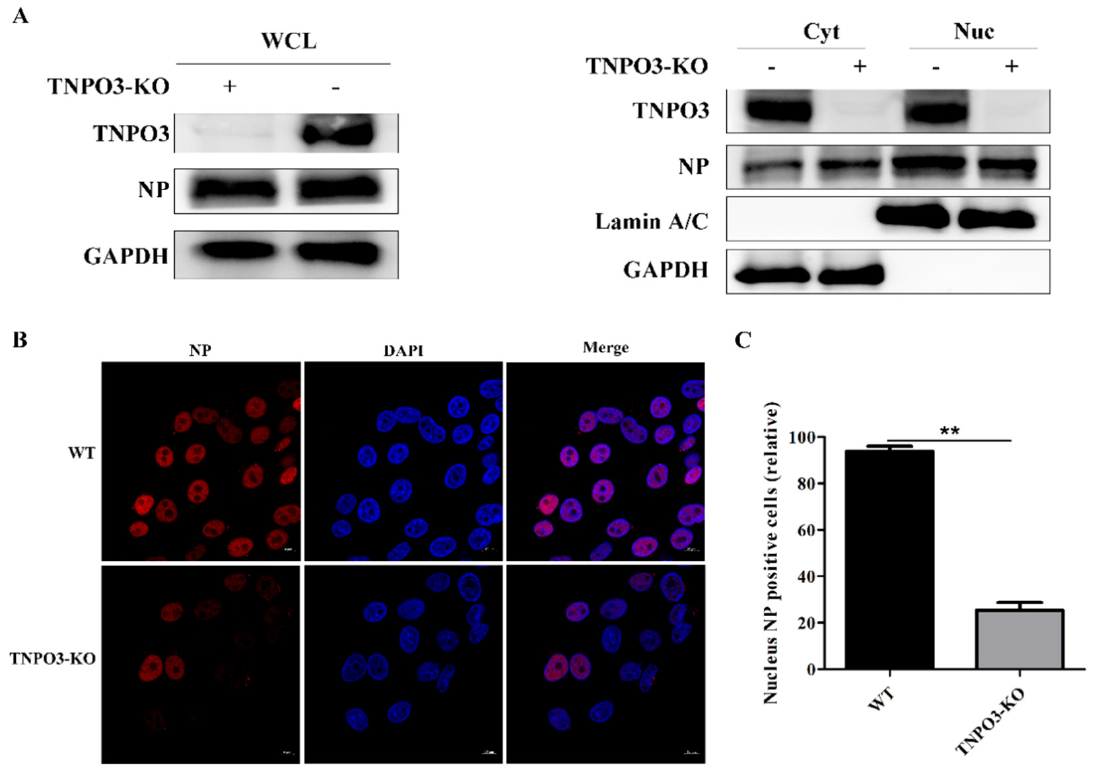
Figure 5. Knockout of TNPO3 inhibits IAV nuclear import. ( A ) Western blot analysis of the distribution of viral NP proteins in the cytoplasmic and nuclear fractions. WT cells and TNPO3-KO cells were infected with HuB/H1N1. Cells were harvested in 3 hpi and subjected to nuclear and cytoplasmic fractionation. Anti-NP antibody was used to determine the IAV content of the nuclear (Nuc) and cytoplasmic (Cyt) fractions as well as the whole-cell lysates (WCL). Lamin A/C was used as a nuclear protein marker and GAPDH was used as a cytosolic protein marker. ( B ) Confocal microscopy of viral-encoded NP in WT and TNPO3-KO cells after virus infection. WT and TNPO3-KO cells were infected with HuB/H1N1 and fixed at 3 hpi for observation. Scale bar = 20 µm. hpi, hour post infection; WT, wild type; KO, knockout; Nuc, nuclear; Cyt, cytoplasmic. ( C ) Analyzing the relative levels of nucleus NP positive cells in two independent experiments, as shown in B (mean ± SD of two independent experiments; **, p < 0.01; two-tailed Student’s t-test).